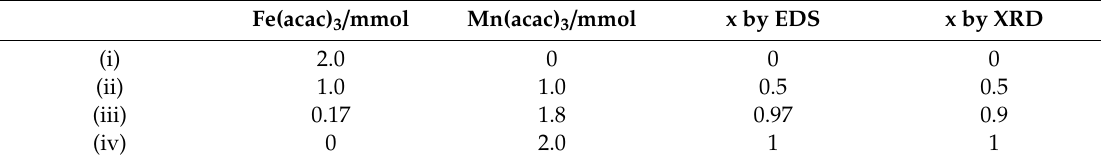
Table 1. The ratio of acetylacetone complex in the source materials to prepare Fe 1 − x Mn x O nanoparticles was shown in the first and second rows. acac stands for acetylacetone. The volumes of oleylamine and oleic acid (solvents) are both 5 mL. Chemical compositions evaluated by energy-dispersive X-ray spectroscopy and X-ray di ff ractionwere shown in the third row and fourth row,